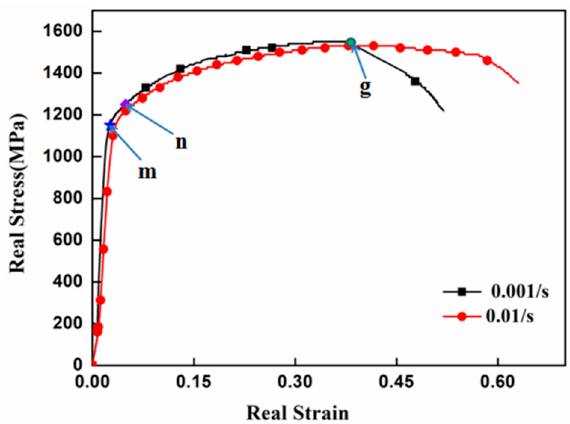
Figure 3. Stress–strain relation curve at room temperature quasi-static.